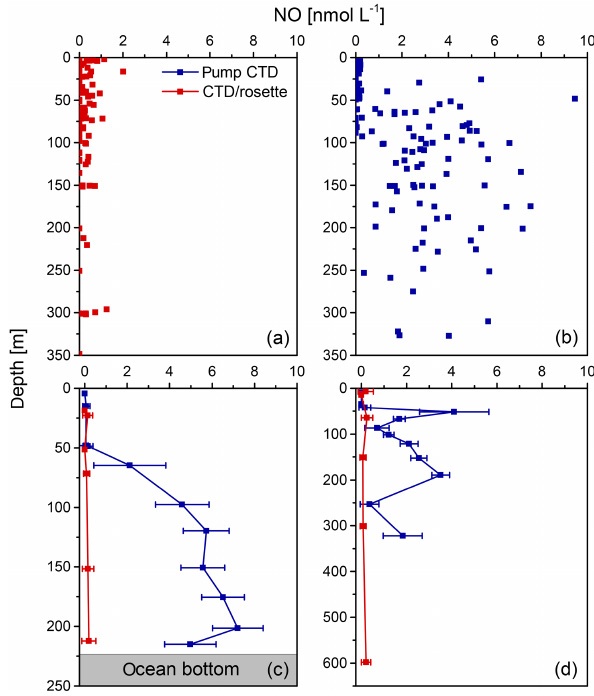
Figure 4. Comparison of the NO measurements from the CTD/rosette (red) and from the pCTD (blue). (a–b) All NO mea- surements during M93 between 0 and 350m. (c) M93 station 411- 6 at 12.377 ◦ S, 77.388 ◦ W. (d) M93 station 391-4 at 12.668 ◦ S, 77.821 ◦ W; the bottom depth was